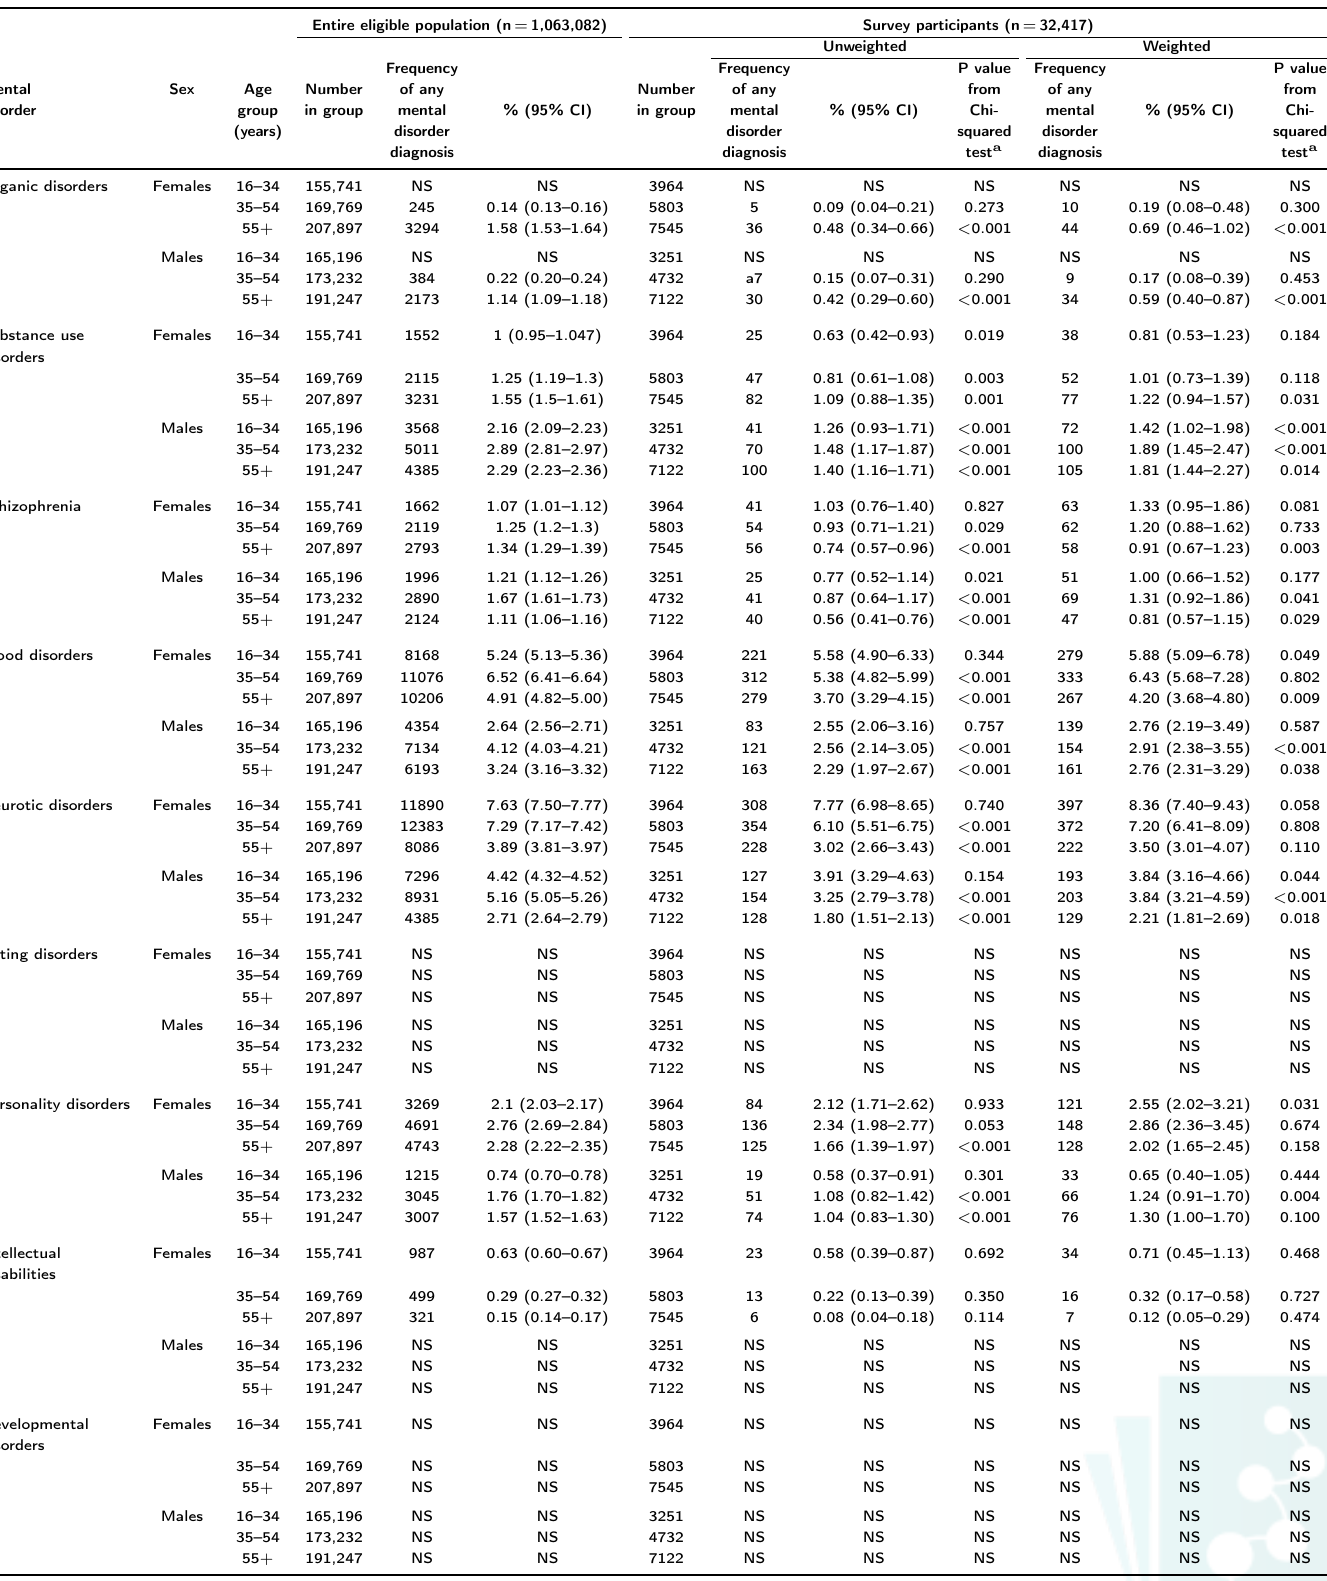
Supplementary Table 6: Frequency of diagnoses of types of mental disorders in specific sex- and age-groups within the eligible population in the Central Denmark Region and the How are you? survey participants (unweighted and weighted) Entire eligible population (n =